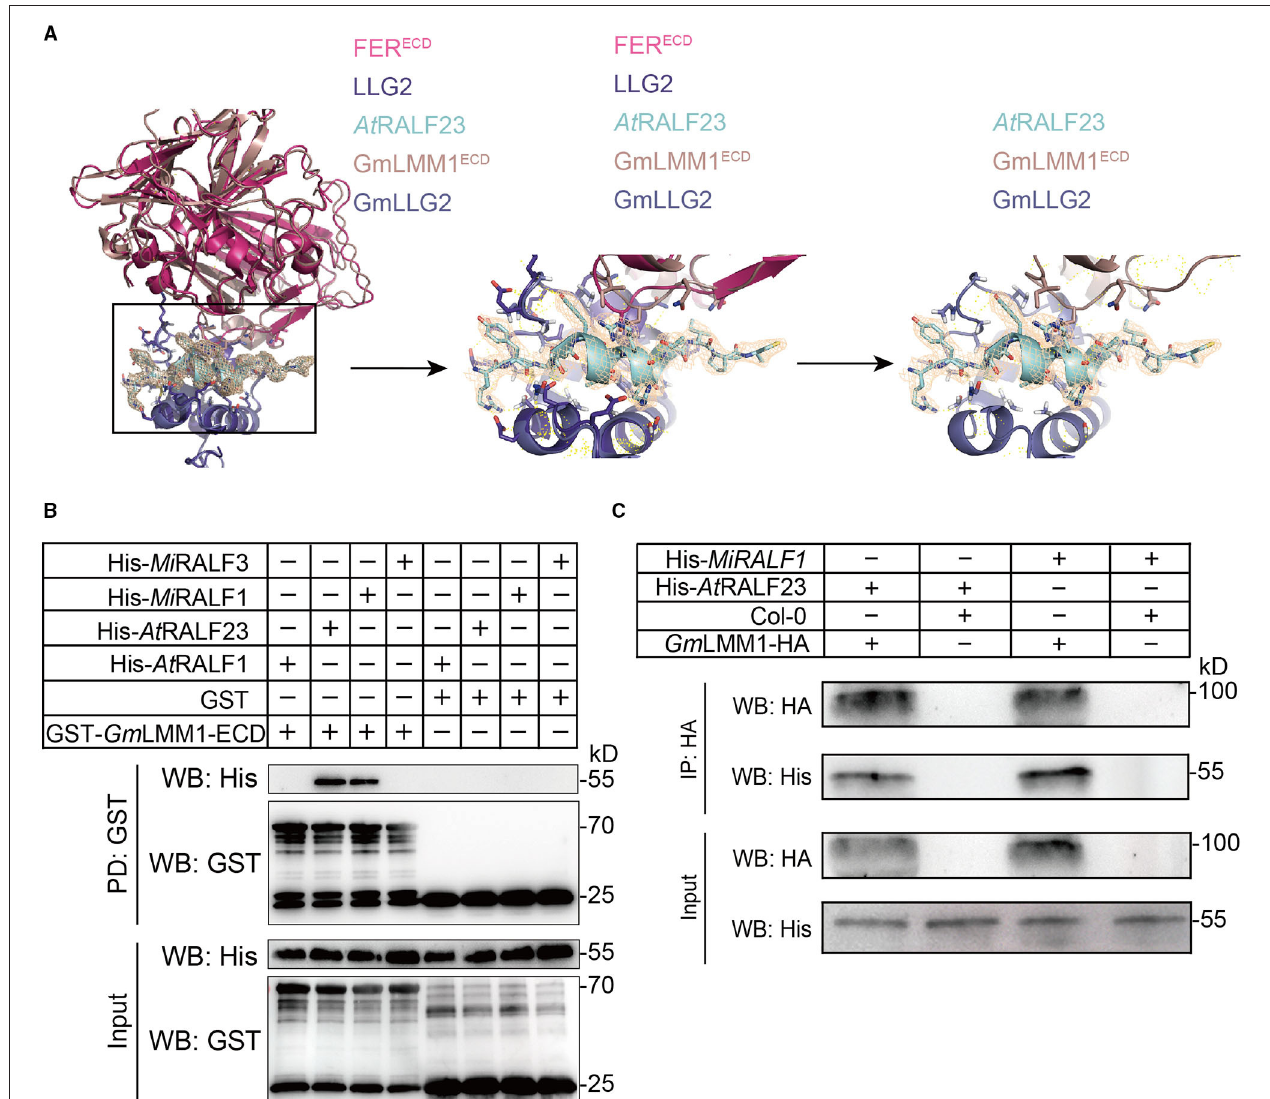
FIGURE 4 | The binding assay of plant or nematode RALFs to GmLMM1. (A) The 3D structure of the RALF23-LLG2 (GmLLG2)/FER ECD (GmLMM1 ECD ) complex. RALF23, LLG2, and FER ECD are colored light cyan, dark blue, and rose red, respectively. The 3D structure of GmLLG2 and Gm LMM1 ECD was conducted by homologously modeling in COOT. The yellow mesh represents the 2Fo-Fc electron density map of RALF23 contoured at 1.0 σ . (B) GST pull-down assays. Different RALFs bind to GST-LMM1 ECD . The upper panel was pulled down by GST beads, and the lower panel was input. (C) Co-IP assays of GmLMM1 with RALF/RALF-likes and GmLMM1-HA transgenic plants were used, and RALF/RALF-likes peptides were produced from E. coli strain BL21 Gold (DE3). All experiments were replicated at least three times with similar